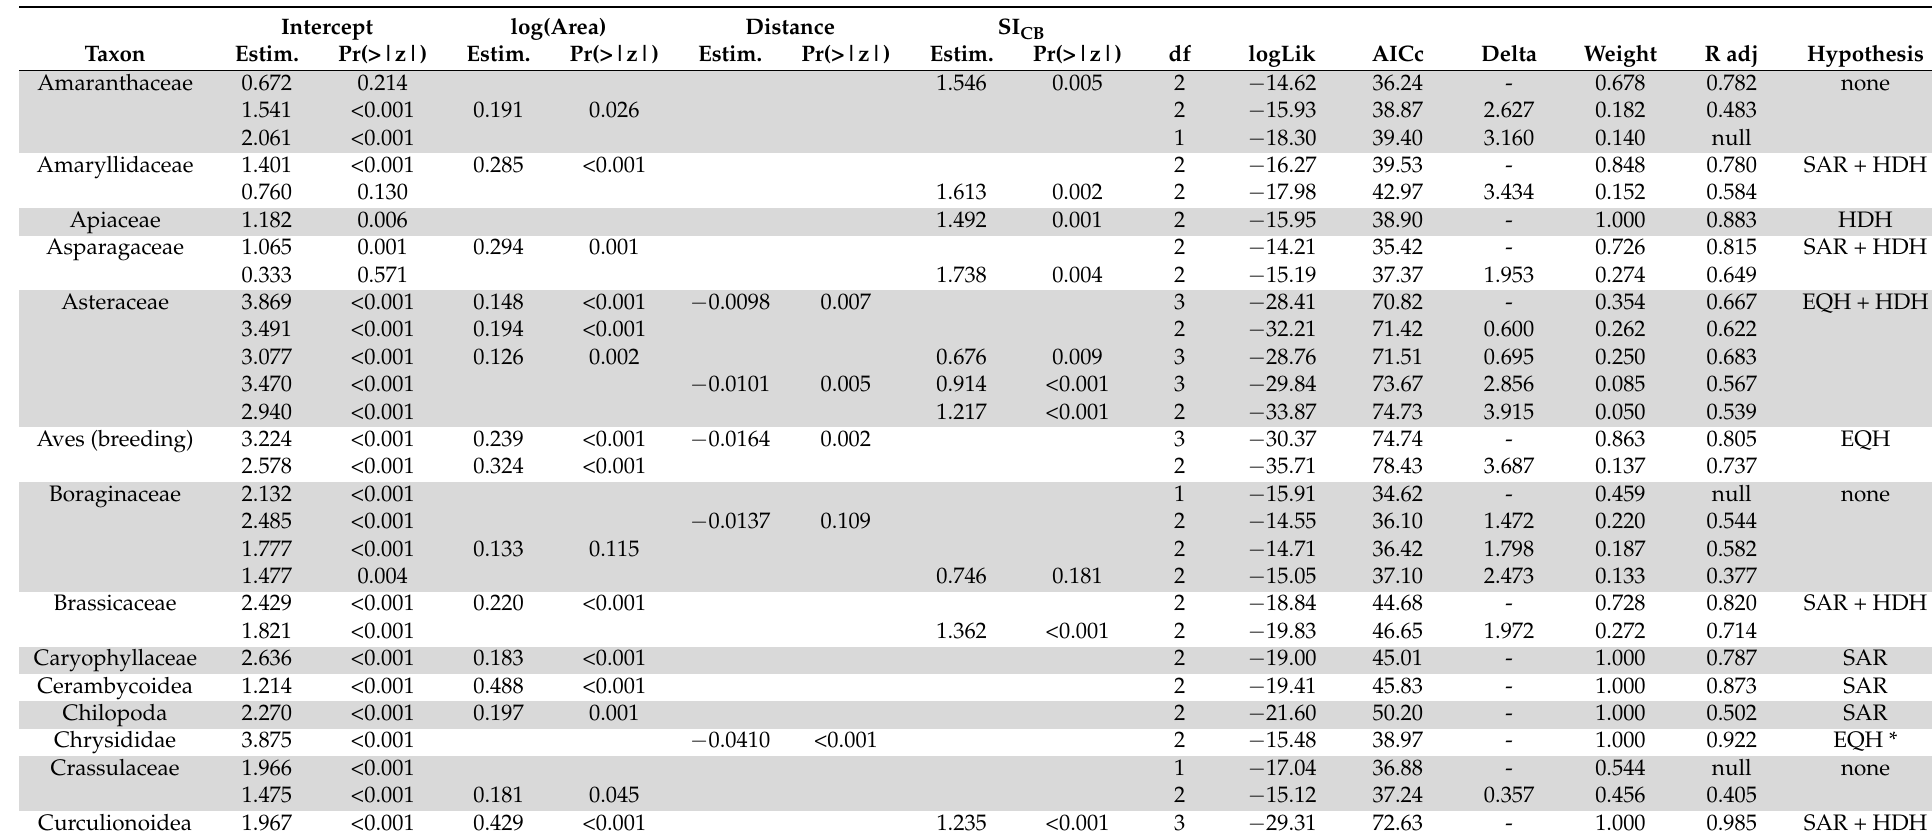
Table 5. Multi-model inference: Automated model selection of best models according to the AICc criterion (delta AICc ≤ 4) and identification of the supported hypothesis. SI CB : Shannon’s Index of CORINE Biotopes; Estim.: Driver coefficient estimate; Pr(>|z|): Two-tailed p -values testing the null hypothesis that the coefficient is equal to zero; df: Degree of freedom of the model; logLik: Log-Likelihood of the model; AICc: Akaike Information Criterion with a correction for finite sample; R 2 adj: Goodness-of-fit of the model according to the adjusted R 2 (null: Null model with intercept only); Hypothesis: Supported hypothesis by our